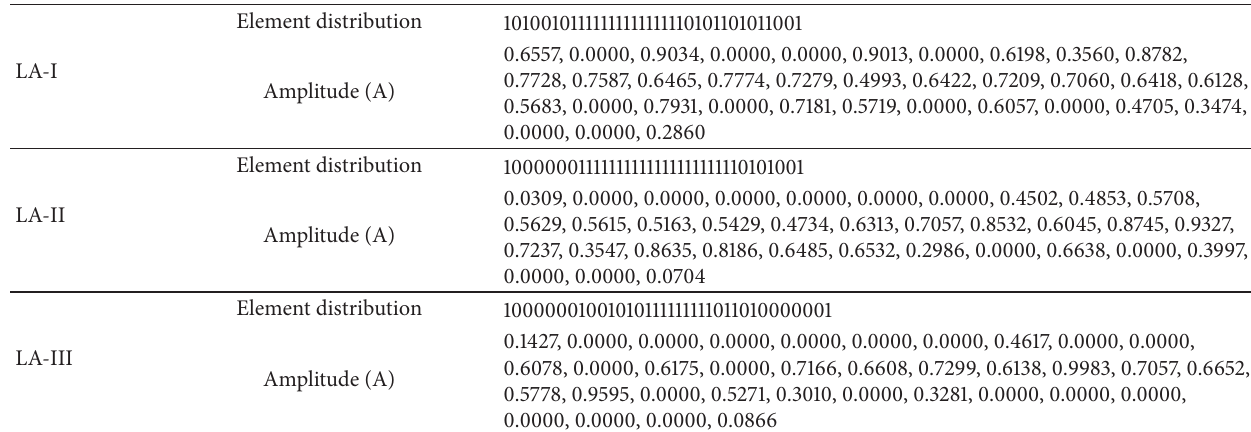
Table 4: Element distributions and optimized amplitudes of the three linear sparse arrays.